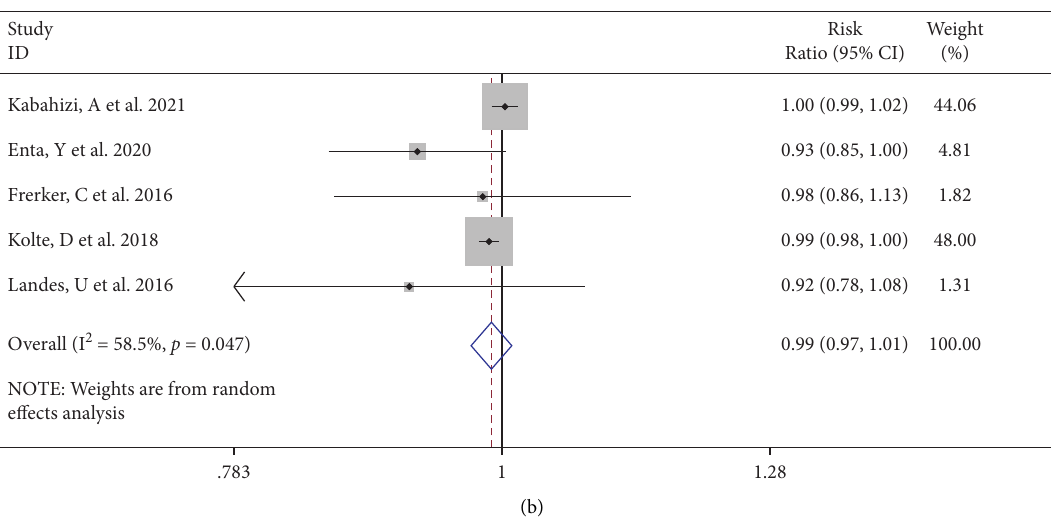
Figure 7: Forest plot showing rehospitalization rate (a) and device success (b) between the emergent TAVI group and elective TAVI group. CI, confidence